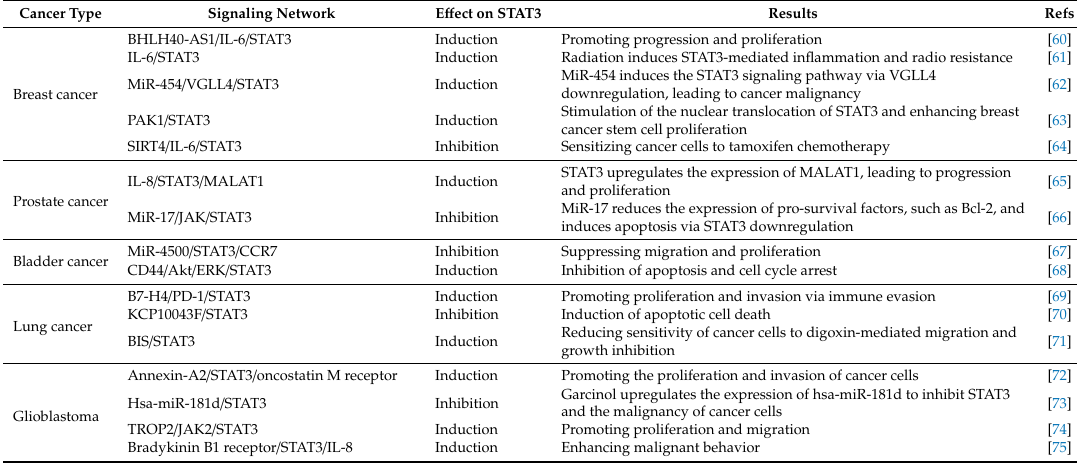
Figure 1. The schematic representation of the STAT3 signaling pathway. Table 1. The role and regulation of STAT3 in di ff erent